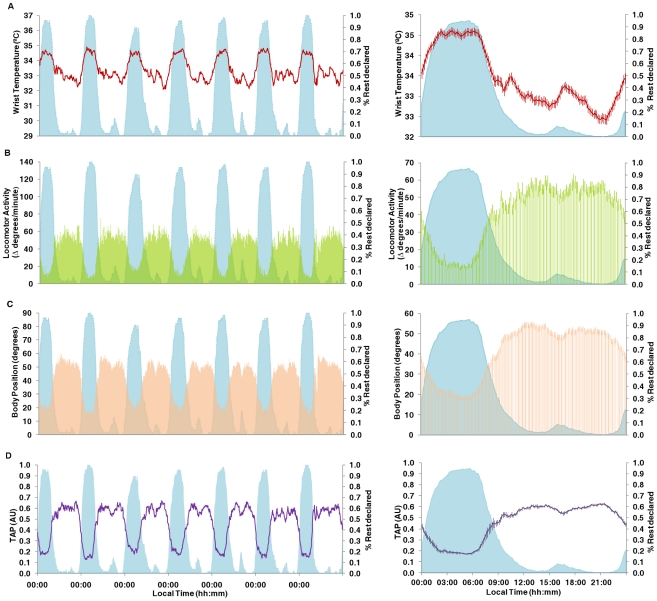
Complete week recording for every variable evaluated for the entire experimental group.On the left it is shown the weekly evolution of each variable and on the right its correspondent mean waveform. Wrist temperature (A) is represented in red, motor activity (B) in green, body position (C) in orange and TAP (D) in violet. On the right, every point is represented as value ± SEM. Please note that scales vary in mean waveforms representations on the right and representations on the left lack of SEM for a better understanding.